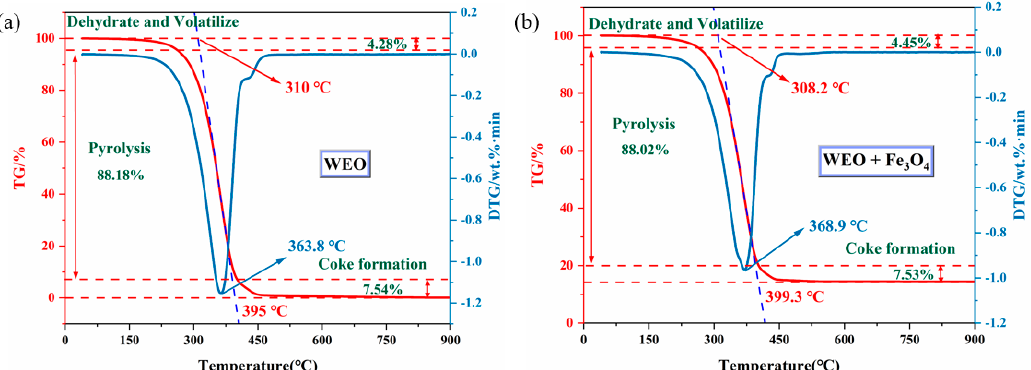
Figure 3. TG − DTG curve of ( a ) WEO and ( b ) WEO with Fe 3 O 4 at a heating rate of 10 °C /min.